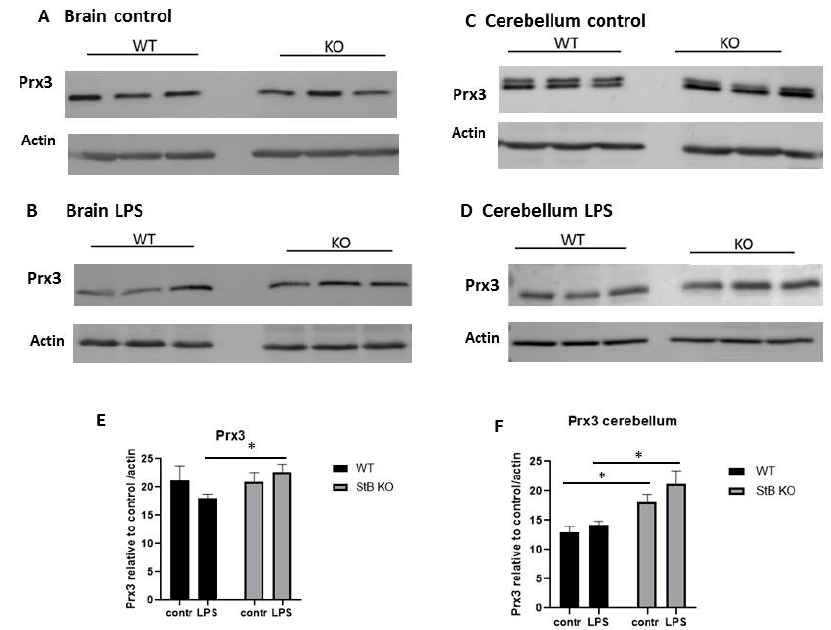
Figure 4. Prx3 in the brain and cerebellar tissue from stefin B deficient (KO) and control (WT) mice after LPS application. Age-matched control FVB/N mice (WT) and stefin B-deficient (KO) (n = 6) were left untreated or were injected with LPS (3 mg/kg body weight). 4 h after LPS challenge animals were sacrificed. Brain tissue lysates ( A ) and cerebellar tissue lysates ( C ) from control mice or LPS injected animals ( B , D ) were analyzed by Western blots with antibodies against Prx3. Anti β -actin antibodies were used as loading controls. The levels of Prx3 in brain lysates ( E ), and Prx3 in cerebellar lysates ( F ) from wild type (WT) and stefin B-deficient (KO) mice in comparison to β -actin controls were quantified by ImageJ. Statistically significant differences vs. control group, * p < 0.05.